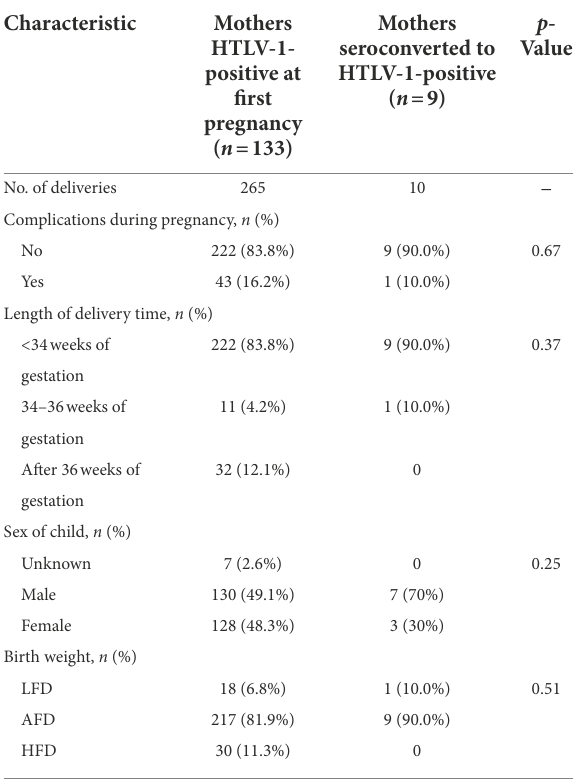
TABLE 2 Pregnancy outcomes in mothers with known HTLV-1- positive status and mothers with HTLV-1 seroconversion during